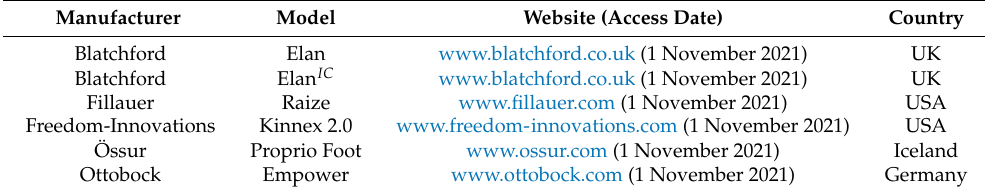
Table 1. Commercial active and semi-active foot prostheses with composite elastic